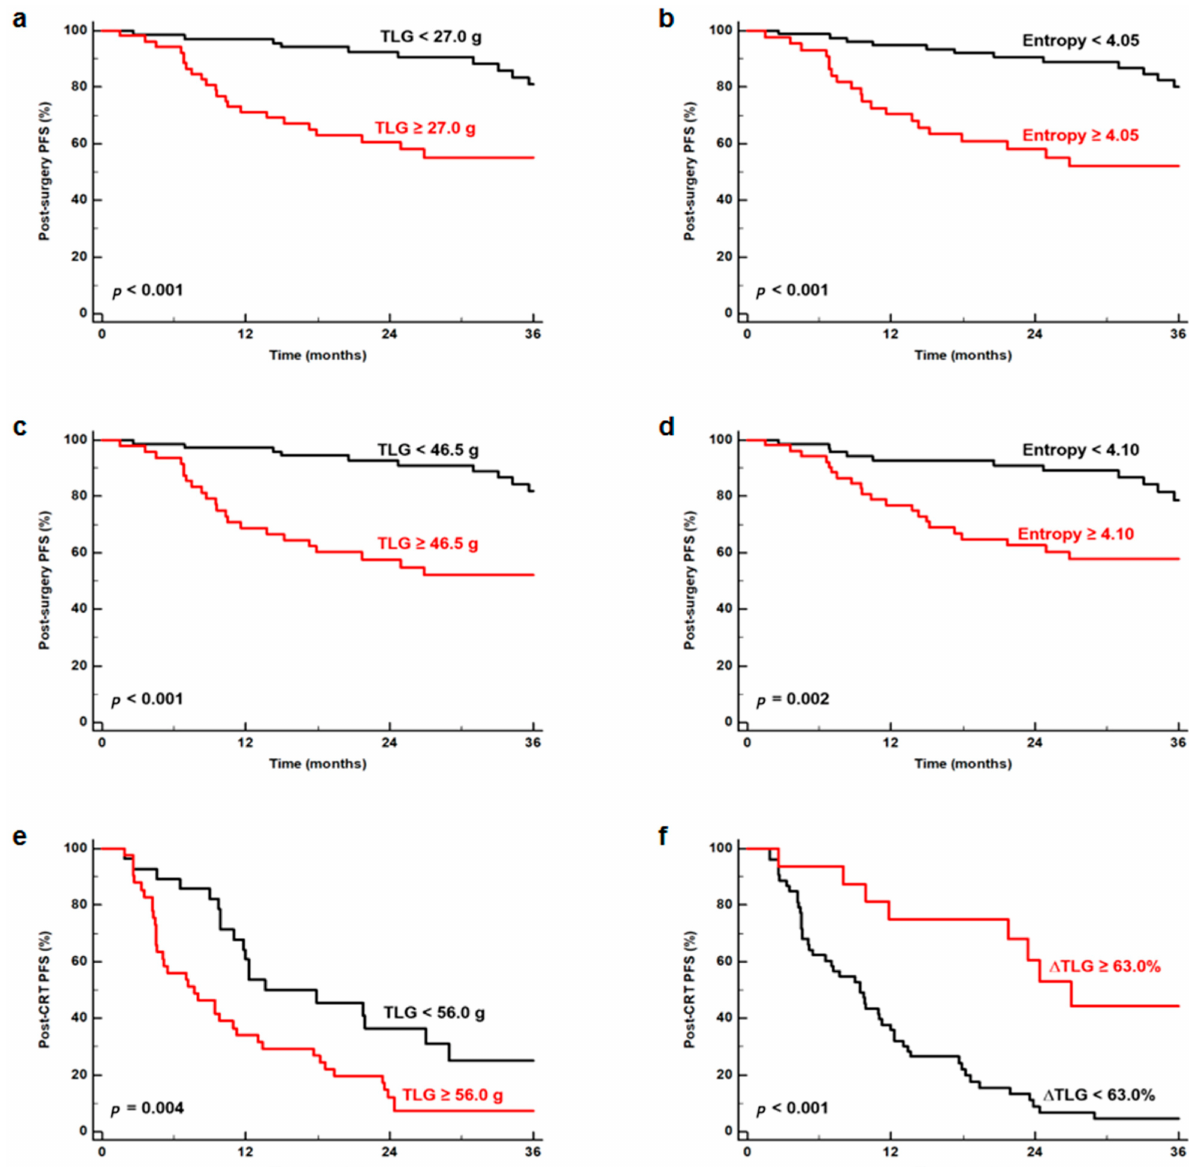
Figure 2. Kaplan–Meier curves for PFS according to TLG ( a ) and entropy ( b ) in the early PET scans and TLG ( c ) and entropy ( d ) in the delayed PET scans in the surgery group (n = 121). Kaplan–Meier curves for PFS according to TLG ( e ) in the early PET scans and ∆ TLG ( f ) in the CRT group (n =